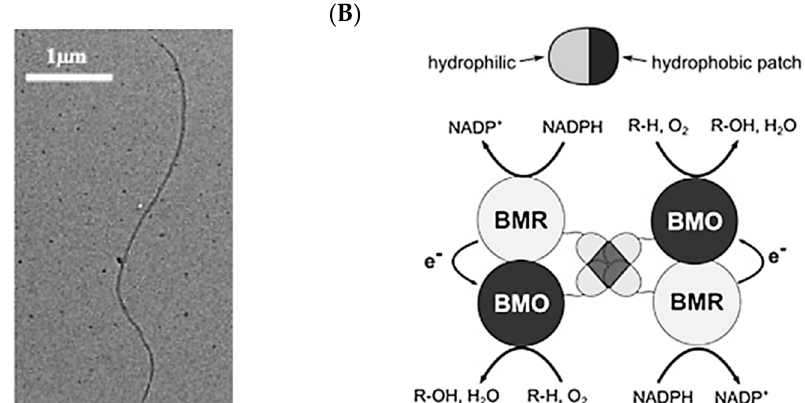
Figure 8. Hydrophobins as a novel platform for enzyme immobilization. ( A ) Vmh2 forms fibrils in solution. Reprinted from Giardina and co-workers [108]. Copyright 2017 Wiley Publications. ( B ) The HFBI hydrophobin brings CYPP450 reductase (BMC) and monooxygenase (BMO) domains in close proximity to each other, facilitating electron exchange. Reprinted from Urlacher and co-workers [110]. Copyright 2016 Frontiers Media.